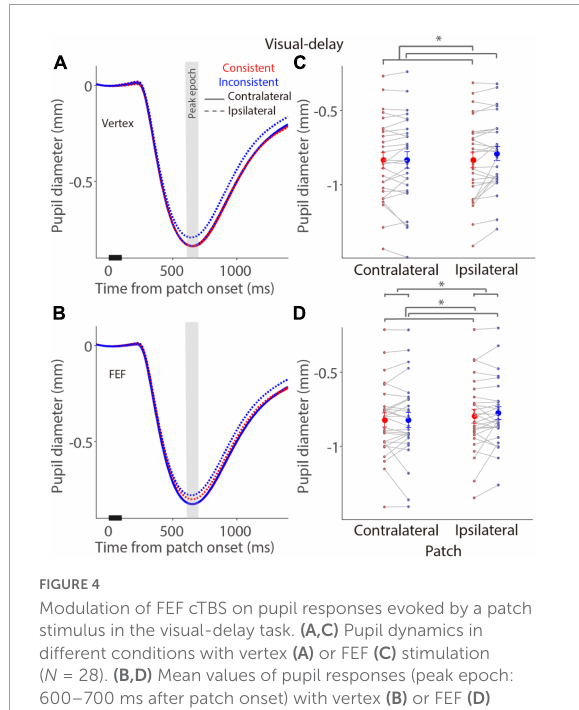
FIGURE5 Modulation of FEF cTBS on pupil responses evoked by a patch stimulus in the memory-delay task. (A,C) Pupil dynamics in different conditions with vertex (A) or FEF (C) stimulation ( N = 28). (B,D) Mean values of pupil responses (peak epoch: 600–700 ms after patch onset) with vertex (B) or FEF (D) stimulation. In panels (A,C) , the pupil response epoch is shaded in gray. The black bar on X-axis indicates the time line of patch presentation. In panels (B,D) , the large-circle and error-bars represent the mean values ± standard error across participants. The dots represent mean value for each participant. Contralateral: contralateral stimulus condition (left). Ipsilateral: ipsilateral stimulus condition (right).